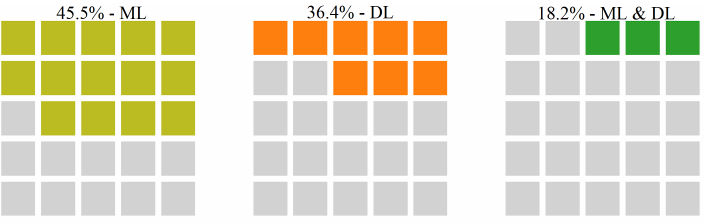
Figure 18. The relationship between Energy Saving challenge and AI techniques categories applied to address